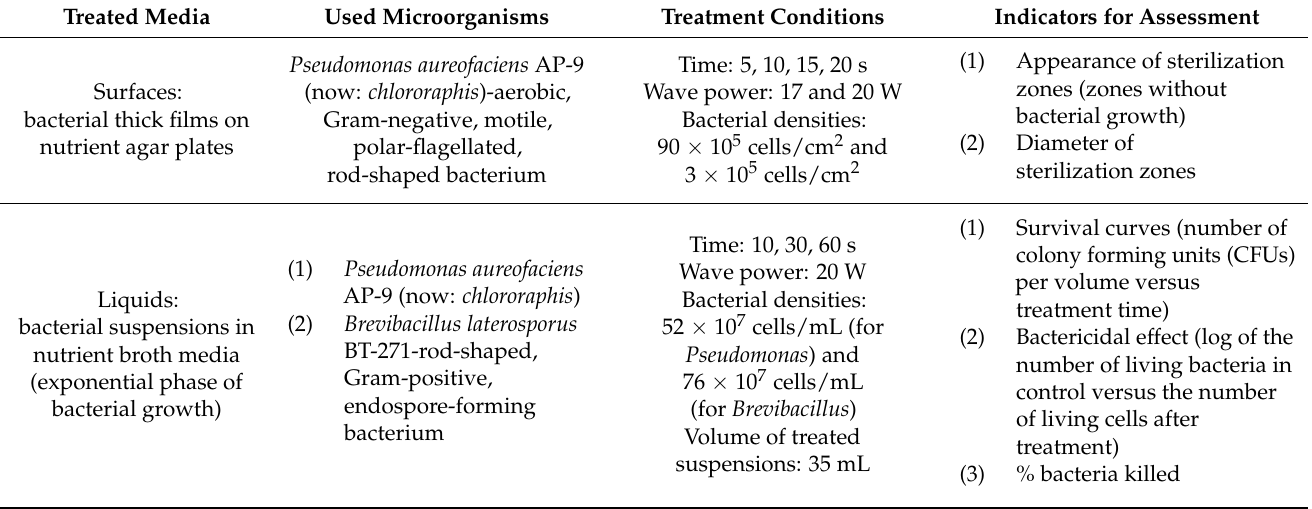
Table 1. Experimental design for assessment of the bactericidal effect of the cold atmospheric argon plasma torch.